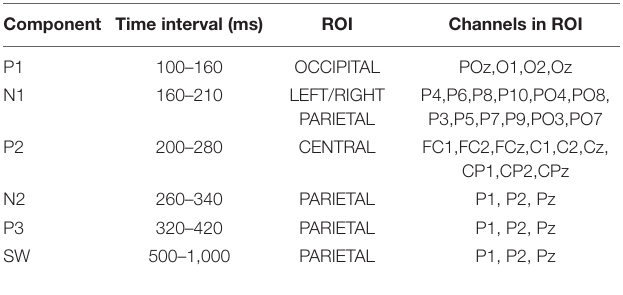
TABLE 1 | Overview of the time ranges and channels used to measure ERP